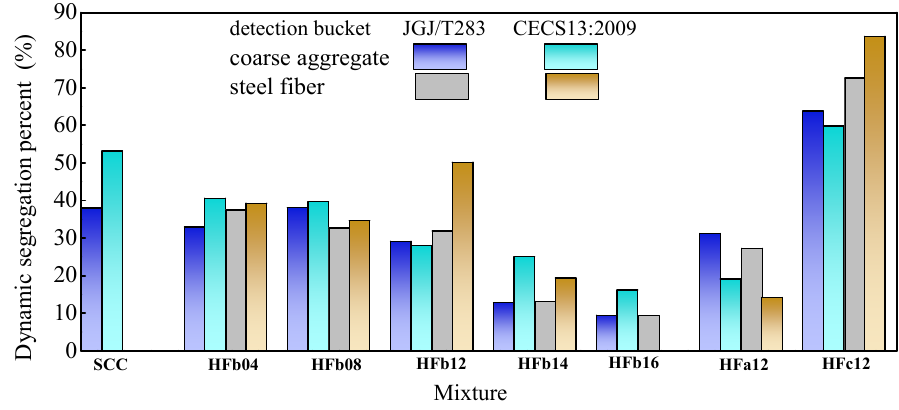
Figure 8. Test results of dynamic segregation percent of mixtures by using different buckets. The test results of dynamic segregation percent of coarse aggregate by using the method of China code JGJ/T 283 [1] are presented in Figure 9. Only HF16 met the requirement of less than 10%; this requirement may be hypercritical. With the prevailing principle of static segregation resistance, the dynamic segregation percent of coarse aggregate in fresh self-compacting SFRC could be taken as 35%.